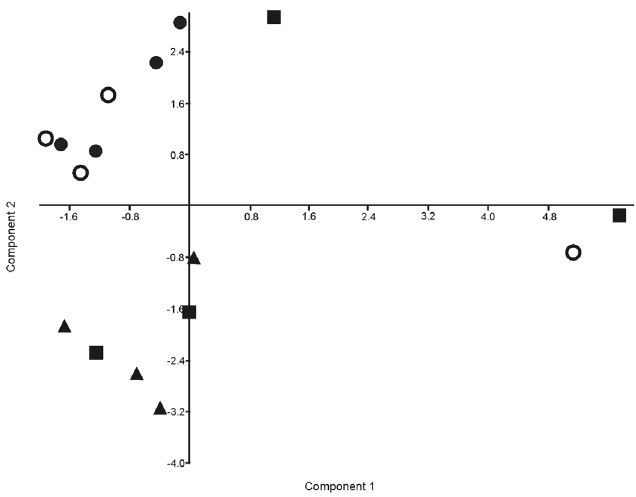
Figure 6. PCA based on the orthopteran samples of four study sites (sites I–IV) (black circle: mowing once a year in May; black square: mowing twice a year in May and September; empty circle: mowing once a year in September; black triangle: